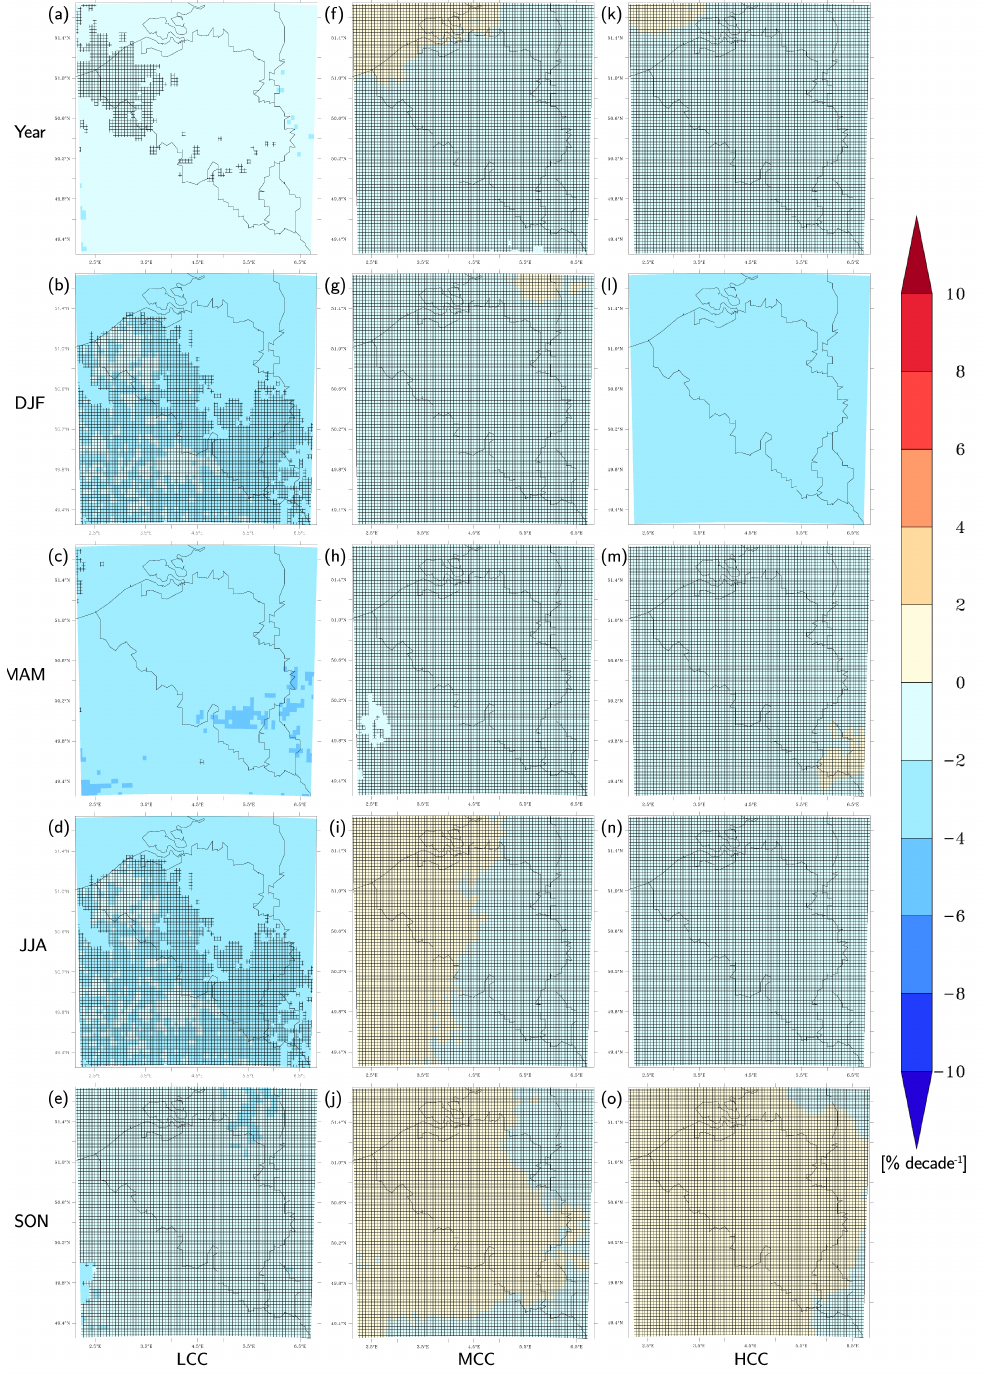
Figure 9. Seasonal trends in ( a – e ) LCC, ( f – j ) MCC, and ( k – o ) HCC computed from the MAR-ERA outputs for 1980–2010 (brightening period). Filled pixels indicate the places where the trends are statistically significant at the 95% confidence level. Hashed pixels indicate the places where the trends are statistically